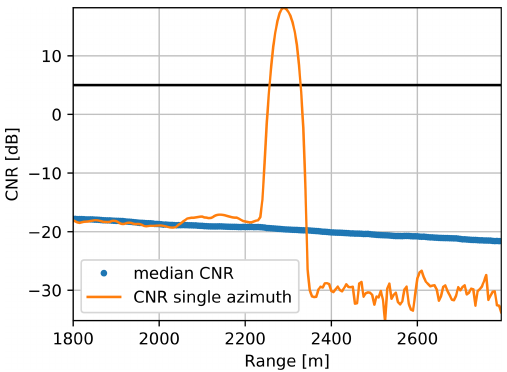
Figure 2. Example of the measured CNR over the range for a hard target scan for a single beam (orange) compared to the median for all azimuth angles (blue). The black horizontal line presents the 5dB